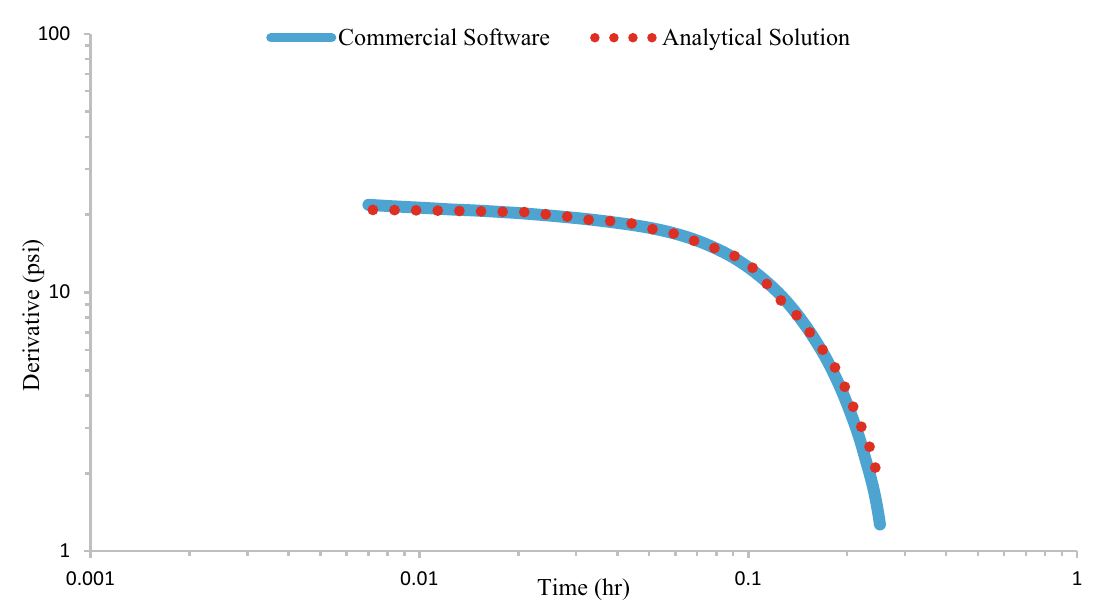
Fig. 13 Sensitivity analysis of scenario No. 4 on the well’s distance in naturally fractured reservoir